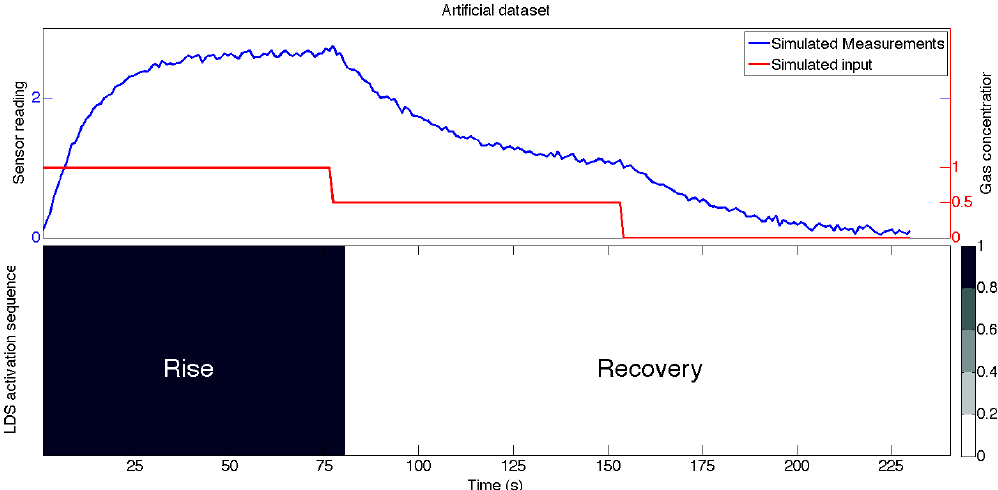
Figure 4. Data for toy example. ( Top ) The simulated sensor measured and the input time series are shown. The time constants for the rise and recovery phases are different. ( Bottom ) the activation sequence of the rise and recovery LDS